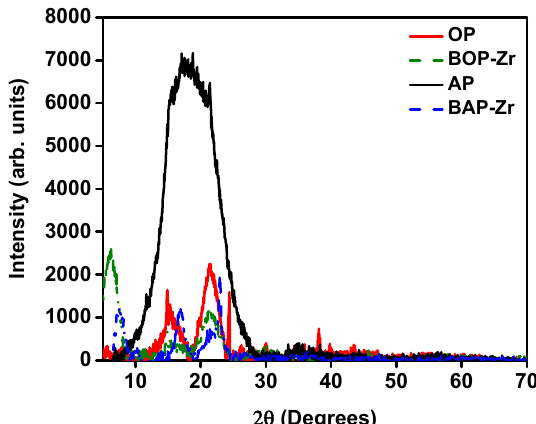
Figure 5. Diffraction pattern, OP (red line) and BOPZr (green-dashed line), AP (black line) and BAPZr (blue-dashed line).